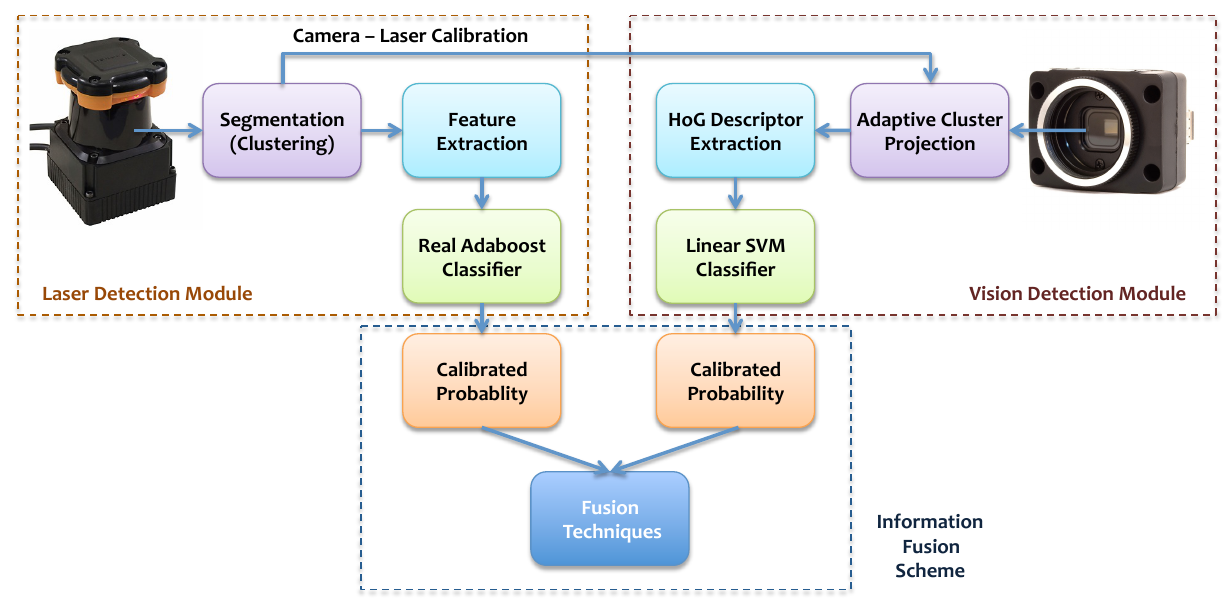
Figure 1. Schematic diagram of the proposed